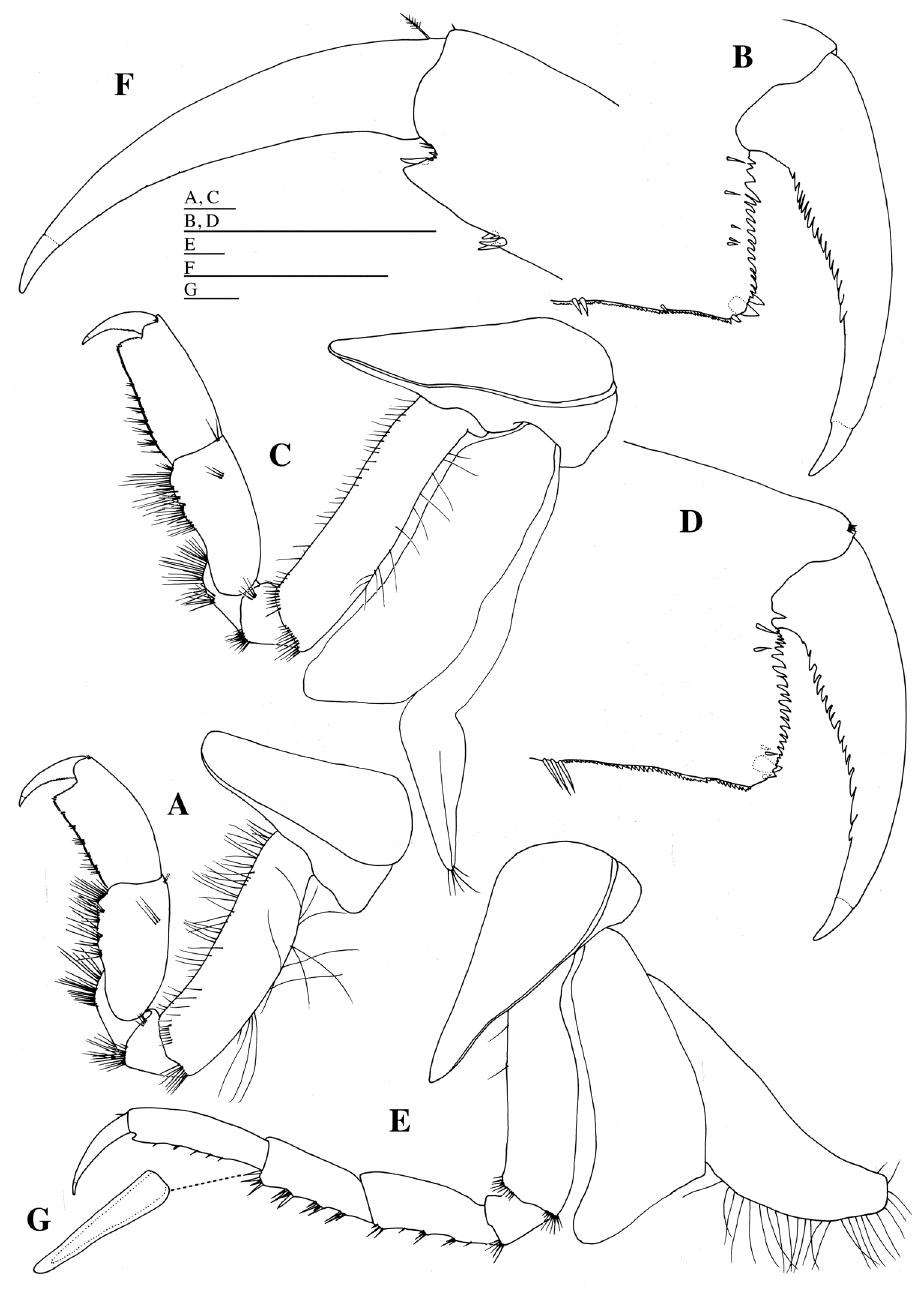
Figure 6. Epimeria abyssalis sp. n., holotype female: A left pereopod 1, lateral B distal part of propodus and dactylus of left pereopod 1, medial C left pereopod 2, lateral D distal part of propodus and dactylus of left pereopod 2, medial E left pereopod 3, lateral F distal part of left pereopod 3, lateral G seta on carpus of left pereopod 3, lateral. Scale bars: 1